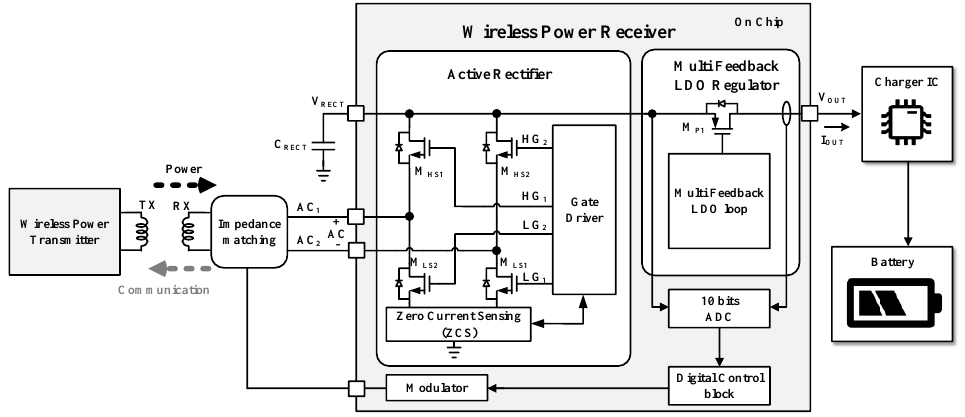
Figure 1. The simplified block diagram of the proposed wireless power receiver.